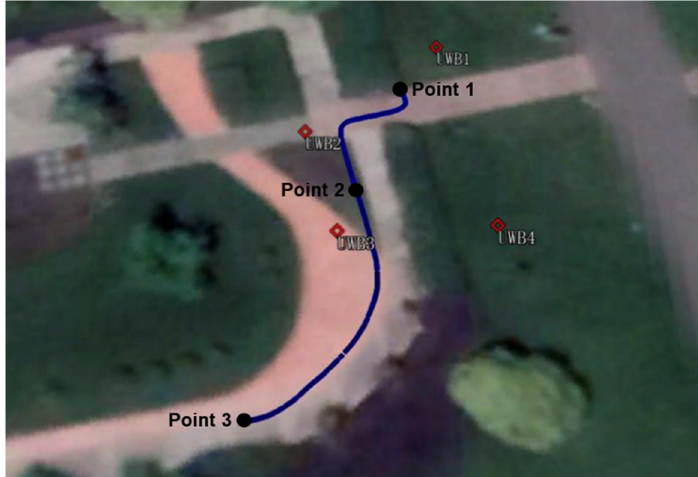
Figure 3. Platform the trajectory of the trolley experiment on Google Earth.